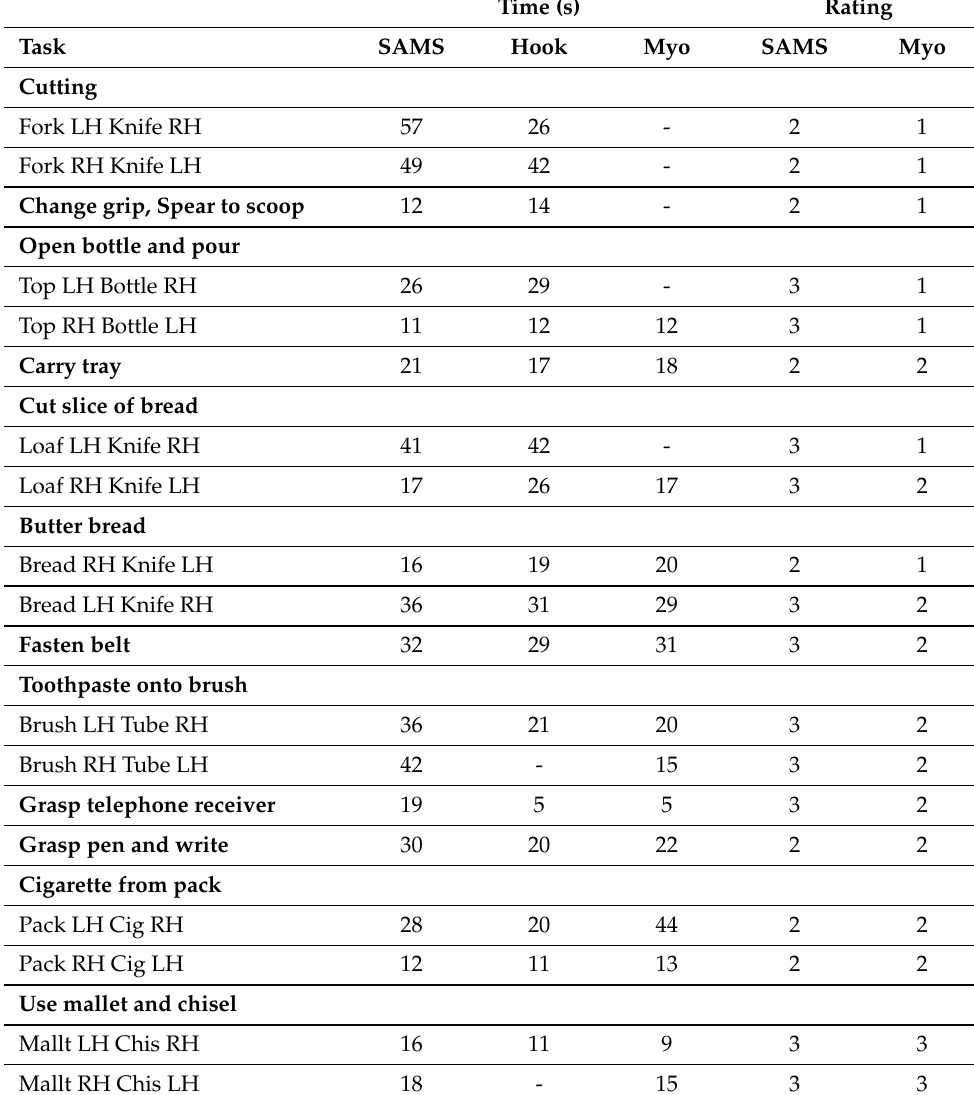
Table 1. Comparison of three controls (RH: Right hand—LH: Left hand) [110]. Time (s) Rating Task SAMS Hook Myo SAMS